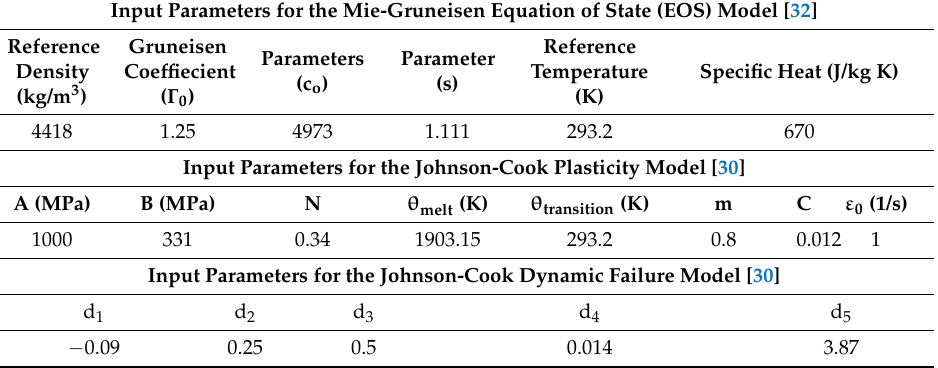
Table 2. Titanium Ti-6Al-4V material properties.